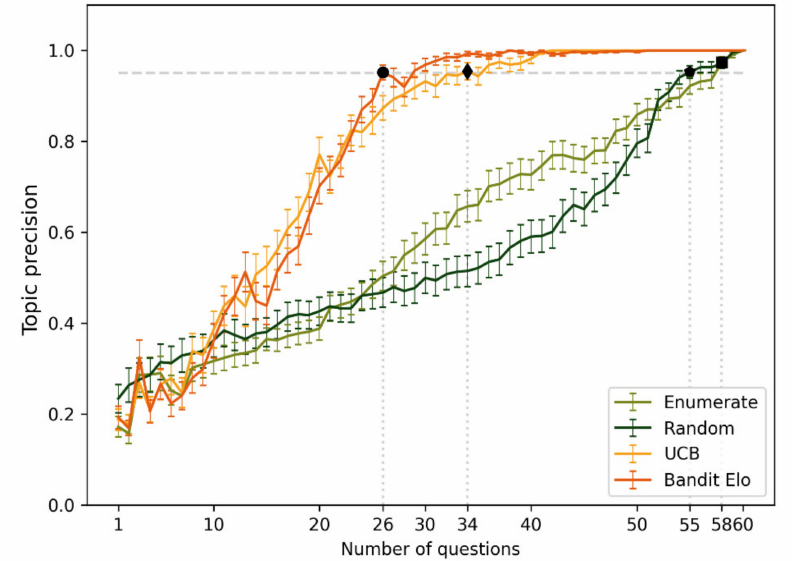
Figure 5. Formative assessment precision selecting topics in CCT as a function of quiz length, 2019 dataset. A vertical dashed line denotes 95% precision.